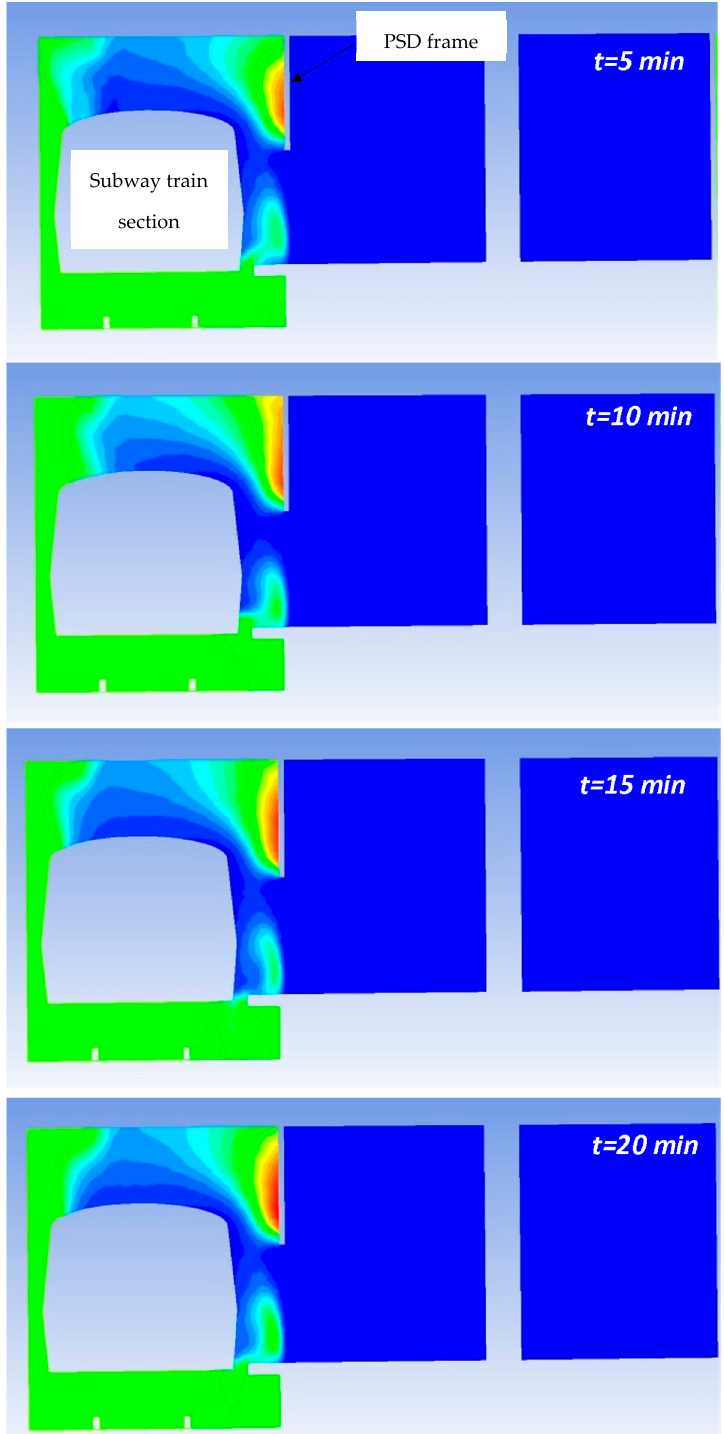
Figure 23. CO 2 contours (ppm)—cross section through the door of the PSD system near the fire outbreak (minutes 5–20).